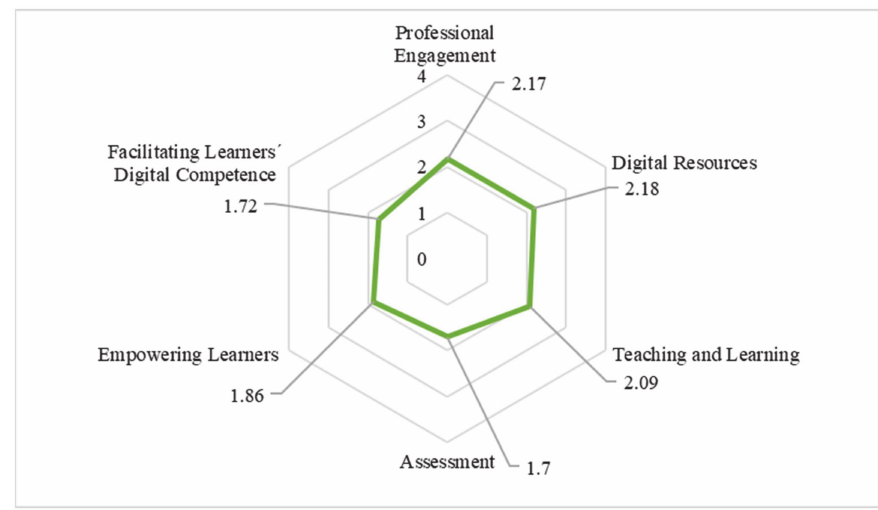
Figure 2. Average value of the competence level by DigCompEdu areas.